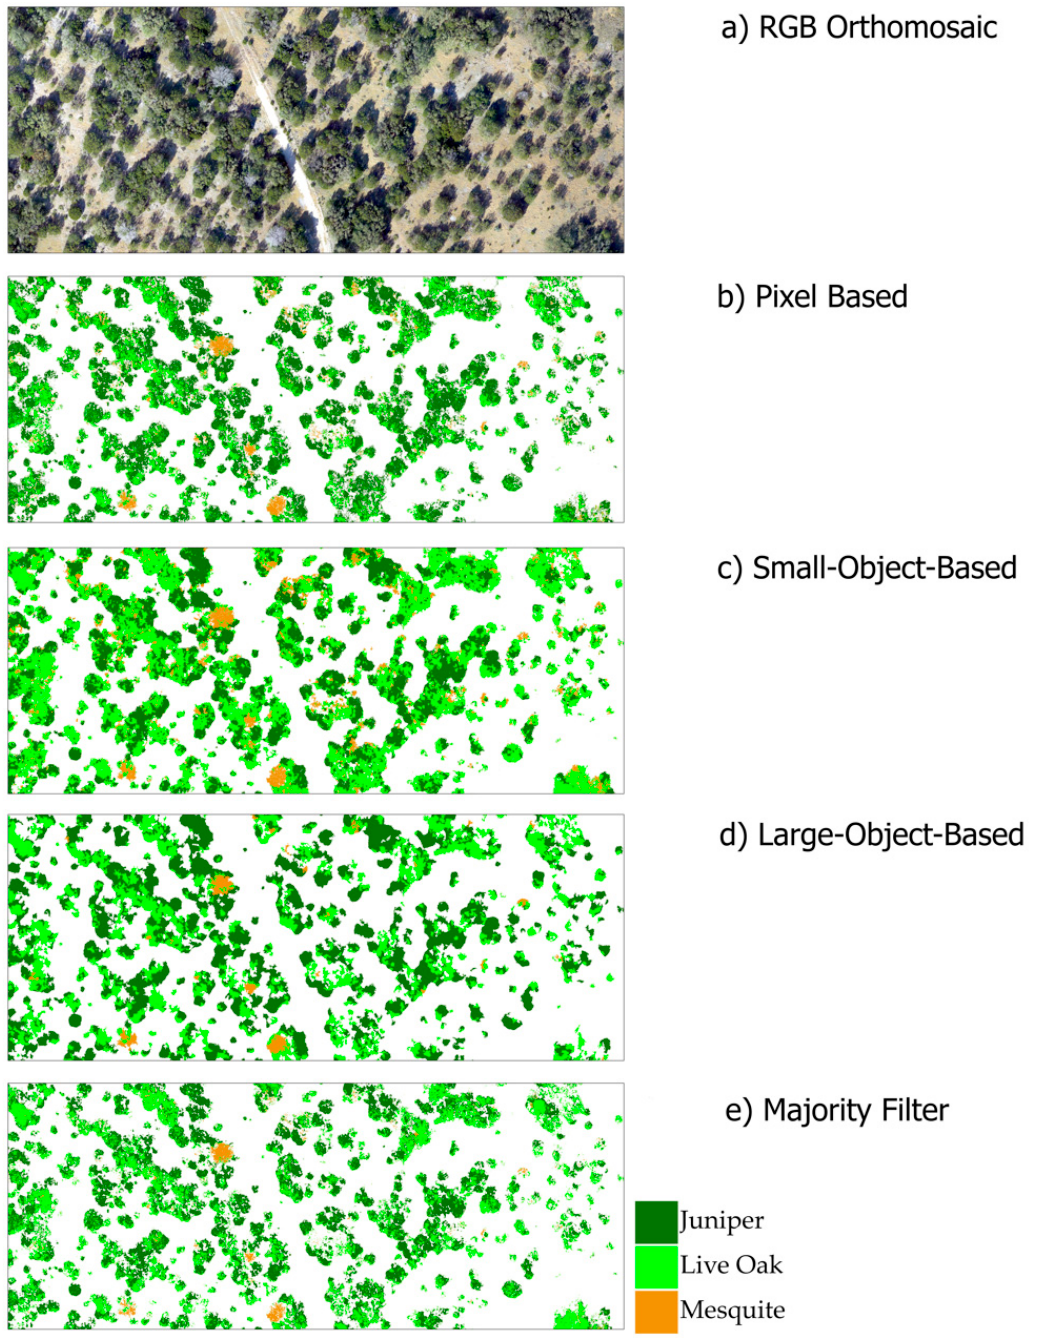
Figure 8. A comparison of the 4 methodologies (using SVM) employed to classify the woody plant species in our study area. ( a ) The 10 cm orthomosaic. ( b ) The pixel-based method provided decent accuracies but suffered from a strong salt-and-pepper effect ( c ) The small-object-based method attained better classification accuracies than the pixel-based method, while also providing a clearer representation of the landscape ( d ) The large-object-based classification most accurately depicted tree canopies; however, it lacked overall and class accuracies, due to a greater number of mixed pixels. ( e ) The post-classification majority filter attained the highest scores overall and class accuracies; however, it tended to underestimate total canopy coverage for all three woody plant species.